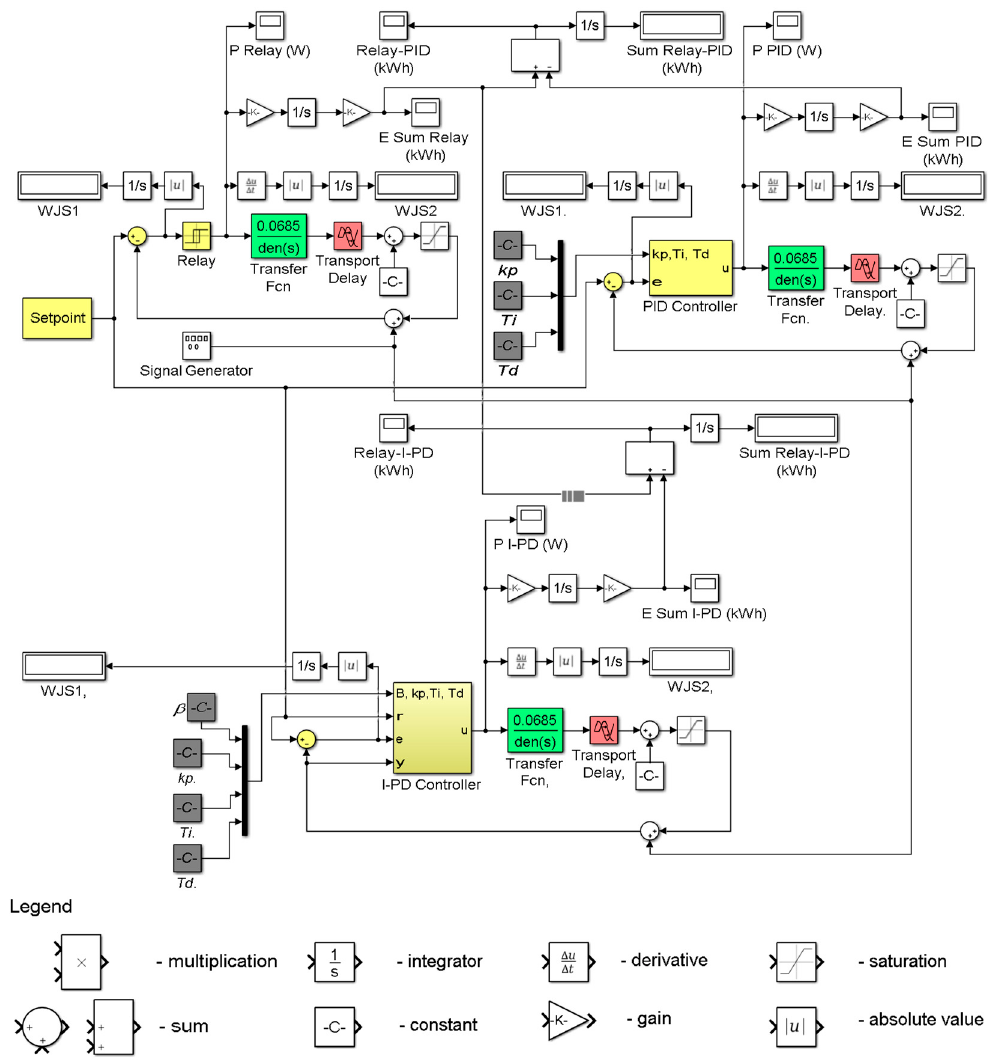
Figure 6. Block schemes of the integrated simulation models of the control systems with relay, PID and I-PD controllers.